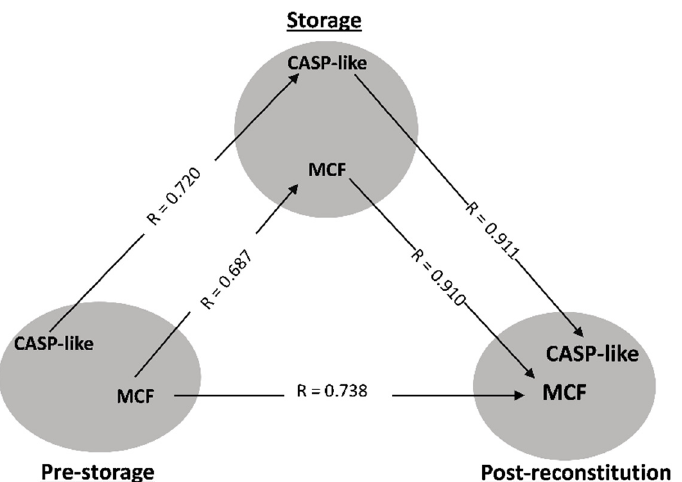
Figure 2. Statistically significant correlations between freshly drawn blood, stored, and reconstituted RBCs from control donors. The correlation triangles focus on osmotic fragility (MCF) and caspase-like (CASP-like) proteasomal activity. All connections represent repeatable (at every recipient plasma and storage time-point measured) significant correlations. The R-values concern late storage and thalassemic